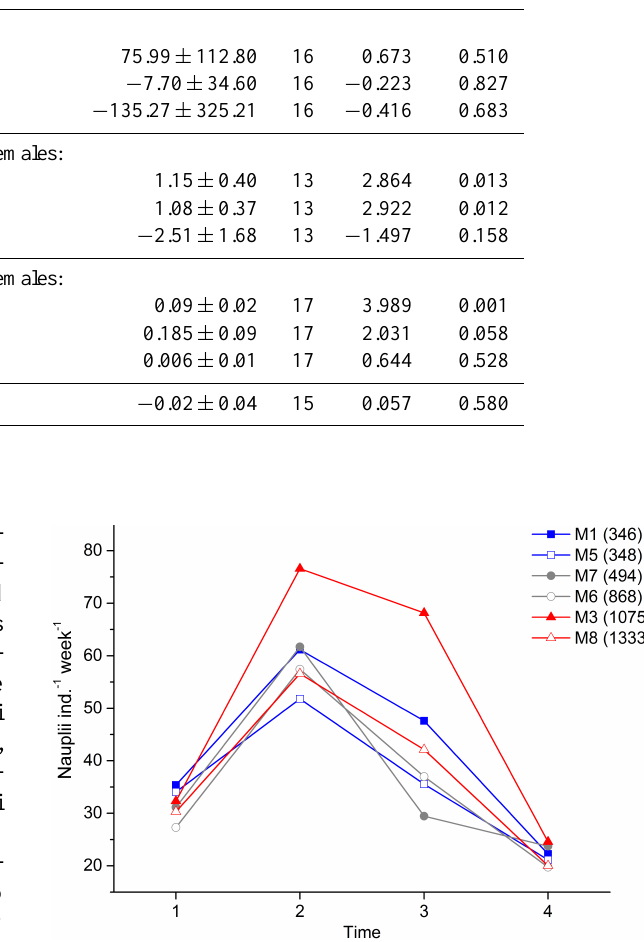
Figure 1. Weekly nauplii production, as averages of 10 females per bottle, for all mesocosms (treatment target f CO 2 in brackets, as averages of t 1 − t 30). Time point 1 is the average weekly nauplii production t 3 − t 7, 2 = t 10 − t 14, 3 = t 17 − t 21, and 4 = t 24 − t